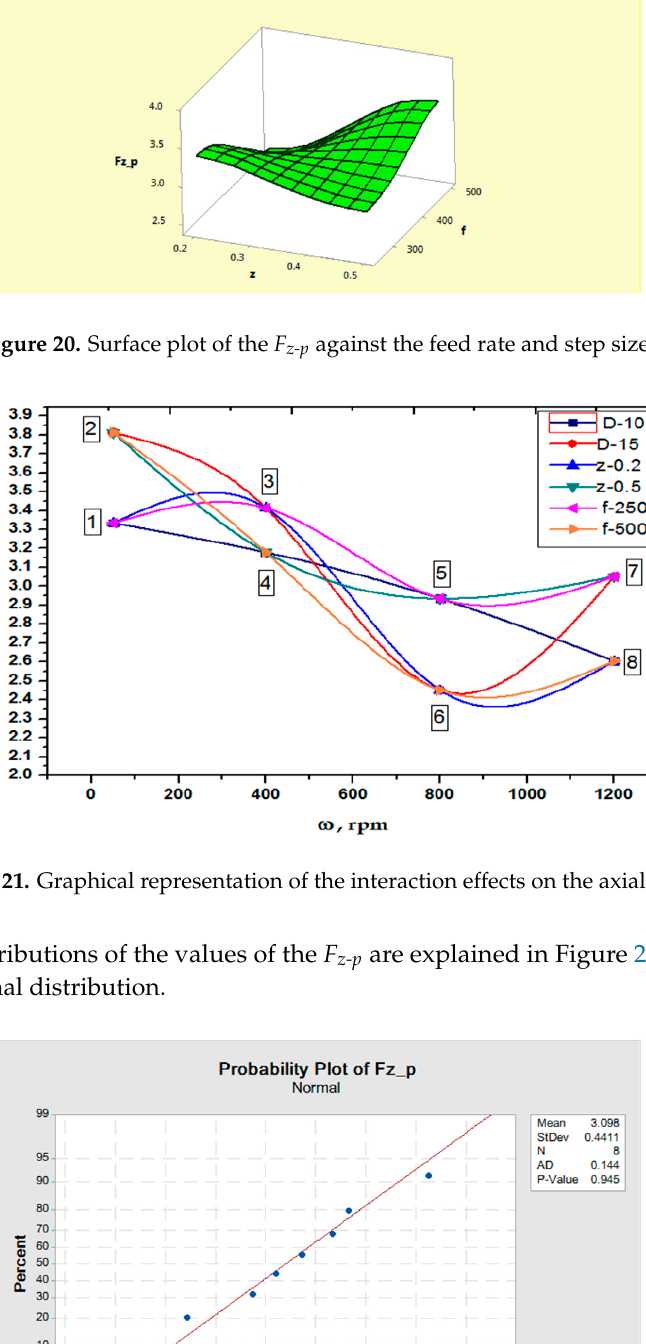
Figure 19. The interactions plot for the F z-p .